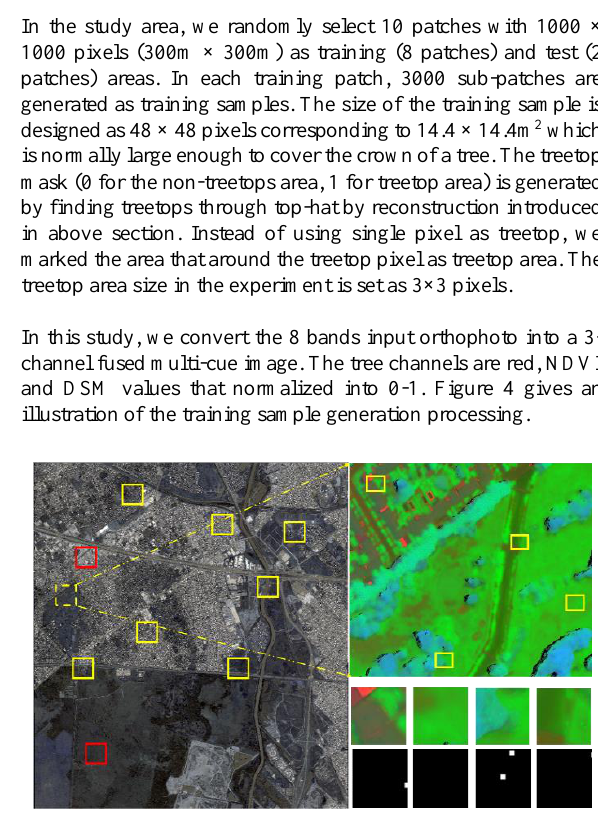
Figure 4. The generation of training samples for the FCN. In the left image, the rectangles represent patches used for training (yellow) and test (red) samples. The right-top image is the 3-channel fused image and the rectangles show four examples of the training samples and their labels (right- bottom).